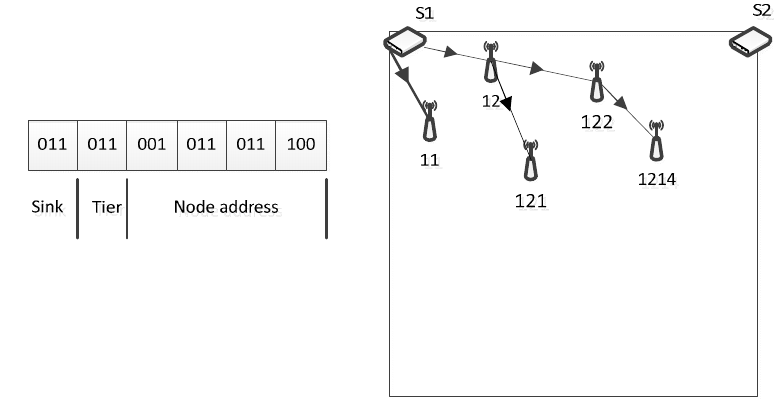
Figure 5. The addressing scheme and configuration using the multi-tiers configuration (adapted from [11,12]).